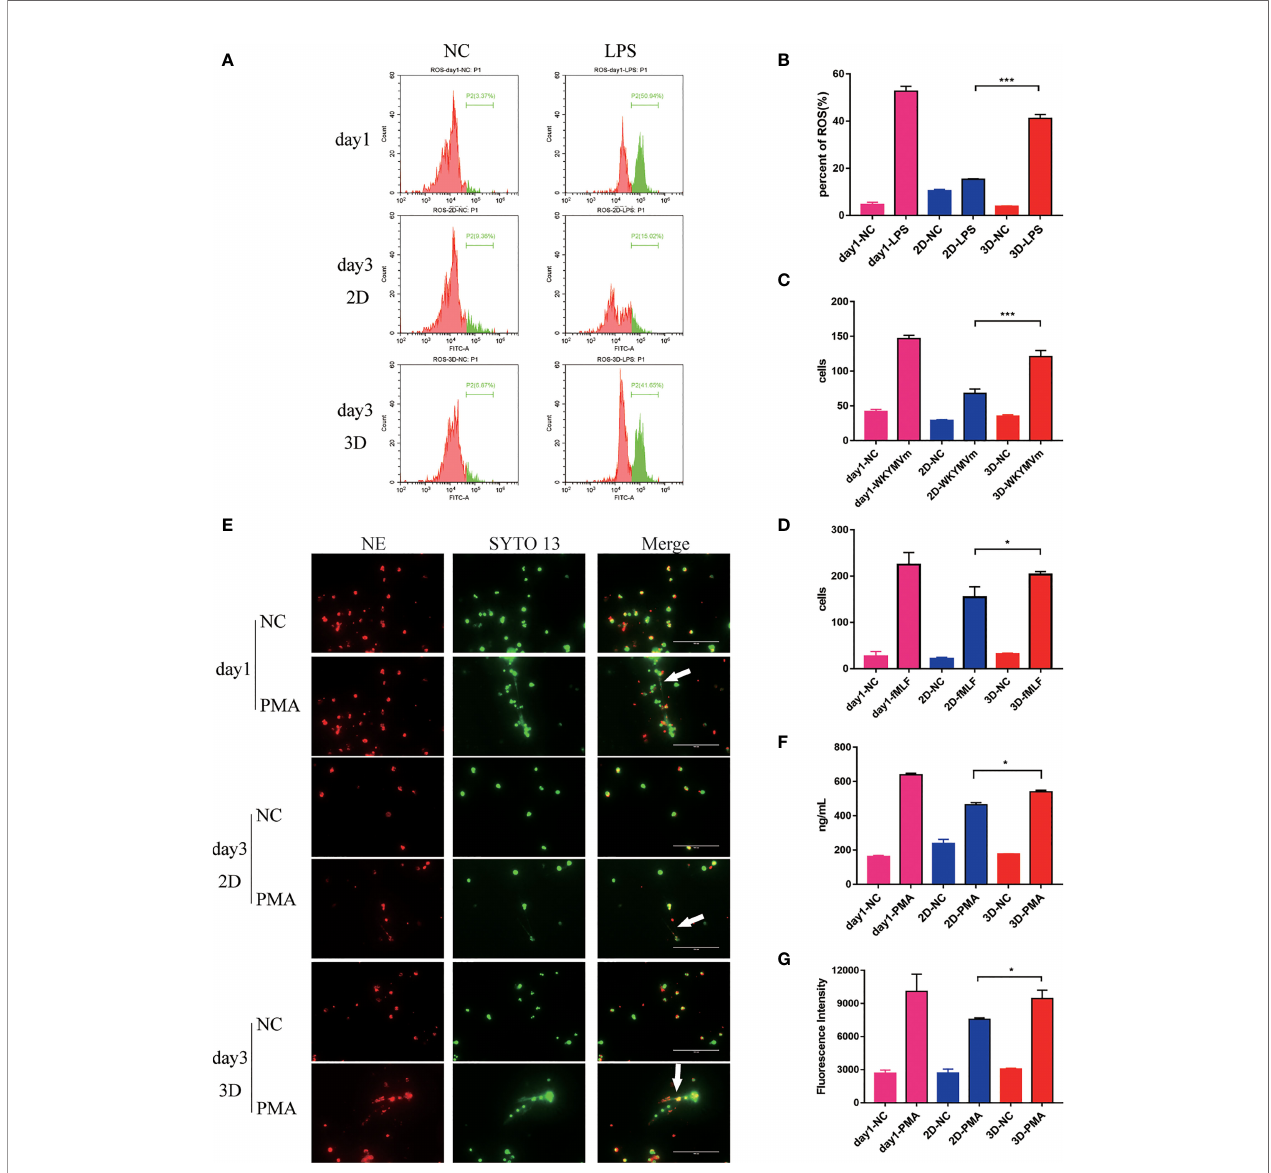
FIGURE 3 | The evaluation of function of Neu during 6 days in 2D and 3D culture system. (A) Flow cytometry analysis of ROS produced by mouse peripheral blood Neu cultured in 2D and 3D systems and corresponding statistical results (B) . Chemotactic ability of mouse peripheral blood Neu shown as the number of cells per high power fi eld on the Petri dish bottom in 2D culture and 3D culture systems for control (randomly migrating) and WKYMVm (100 nM) stimulated mouse peripheral blood Neu (C) or control and fMLF (1 m M) stimulated human peripheral blood Neu (D) . (E) Human Neu released NETs marked by NE (Alexa Fluor 594 dye, red) and nuclear (SYTO 13, green) when stimulated by 20 m M PMA for 4 h in 2D and 3D culture systems under a confocal microscope in vitro . (F) A signi fi cantly different dsDNA release was detected using fl uorescent-based Picogreen assay. (G) Meanwhile, a signi fi cantly different release of neutrophil elastase coupled dsDNA was measured using fl uorescent-based Picogreen assay coated with NE antibodies. Error bars represent mean ± S.D. n = 3, *p < 0.05, **p < 0.01, ***p < 0.001, ****p < 0.0001, ns, not statistically signi fi cantly different by Two way